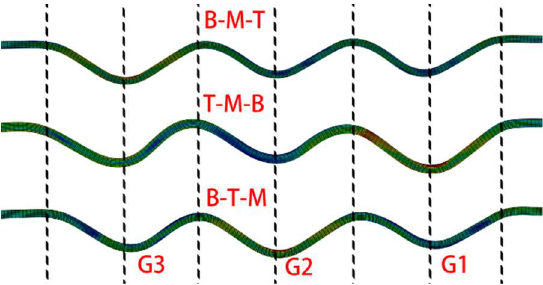
Figure 16. Results of three spinning sequences.